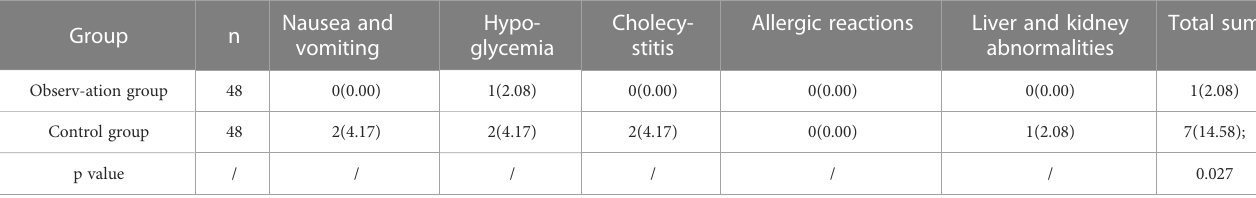
Data are displayed as number and percentage(%).